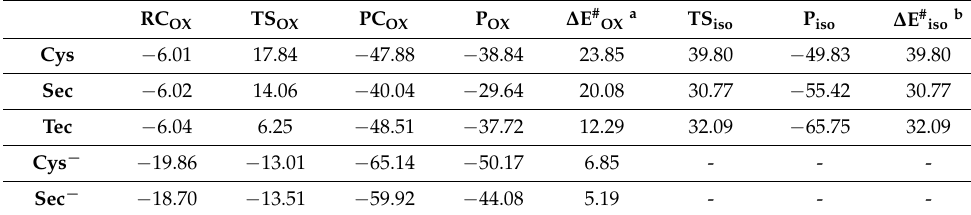
Figure 1. Stationary points along the stepwise oxidation mechanism of Cys/Sec/Tec by H 2 O 2 (see Scheme 10). Relevant interatomic distances are shown in Å. Adapted from [38]. Table 3. Electronic energies (kcal mol − 1 ) relative to free reactants for the oxidation of free protonated (Scheme 11) and deprotonated amino acids (Scheme 13). Level of theory: ZORA-BLYP-D3(BJ)/TZ2P. a Data taken from